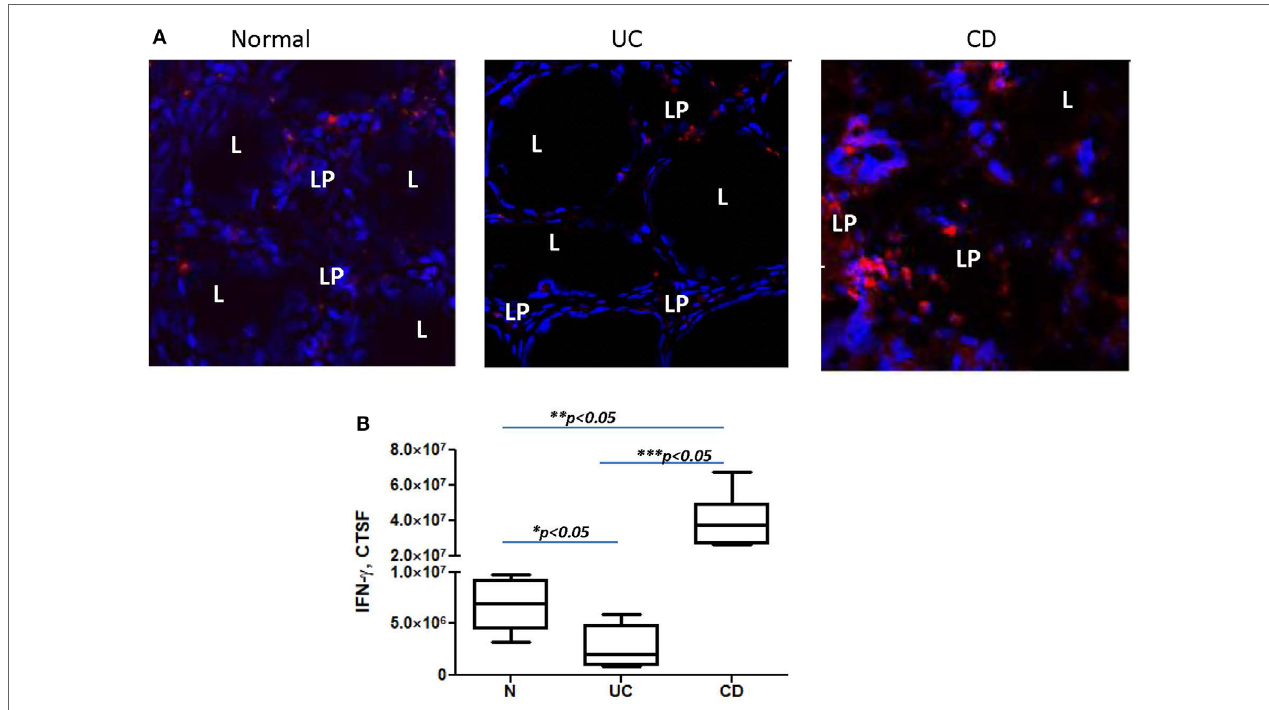
FigUre 5 | IFN- γ expression is decreased in the colonic mucosa of ulcerative colitis (UC) but increased in Crohn’s disease (CD) when compared to normal controls. In these experiments, frozen colonic tissue sections were stained with DAPI to identify cell nuclei (blue) and anti-IFN- γ monoclonal antibodies (clone 4S.B3, in red) and analyzed by confocal microscopy, objective used is 63 × . (a) Representative cross sections of UC, CD, and normal human colonic mucosa and (B) summary of fold changes in the corrected total cell fluorescence (CTCF) of PD-L1 expression in UC, CD, and normal human colonic mucosa (the means ± SEM are shown, n = 5 per group), L, lumen; LP, lamina